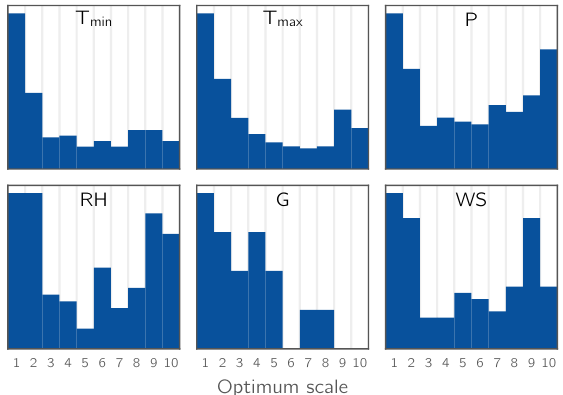
Figure 4. Histograms of the optimum scales for bias correction found using the approach by Hofer et al. (2017) for the variables minimum temperature ( T min ), maximum temperature ( T max ), pre- cipitation ( P ), relative humidity (RH), global radiation ( G ), and wind speed (WS). Histograms are calculated using the derived op- timum scales for all available stations for a given variable and all 14 GCM–RCM combinations (Table